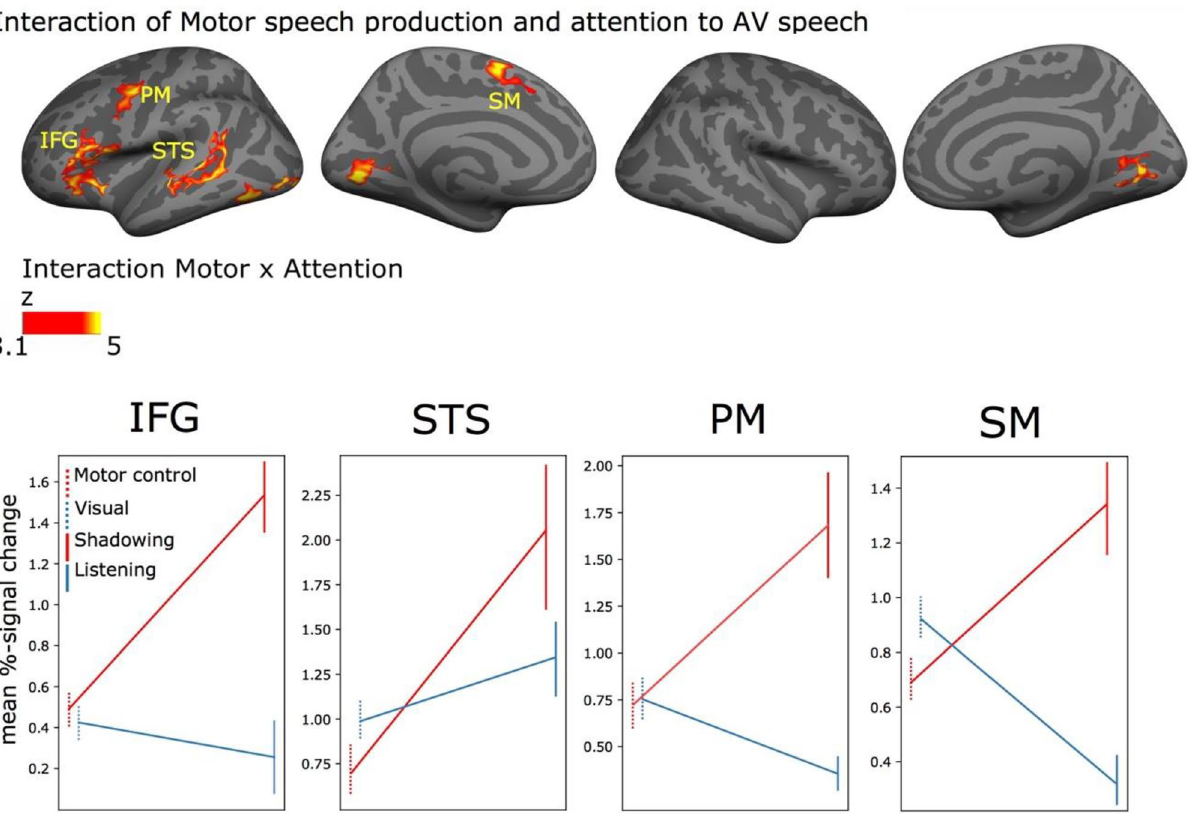
Figure 6. Significant interaction between Motor speech production and Attention to AV speech were found in left hemisphere auditory, motor and language regions. Top row: Significant clusters (initial cluster threshold z = 3.1; permutated cluster significance p < 0.05, FWER corrected) for the interaction Motor speech production × Attention to AV speech. From left to right: lateral and medial views of the inflated left hemisphere and lateral and medial views of the right hemisphere (lighter gray denotes gyri and darker gray sulci). Bottom row: The mean % signal change (vs. baseline) in each of the tasks are plotted separately for select significant clusters, Plots for all interaction clusters are shown in Supplementary Fig. 1. Error bars represent ± SEM. IFG inferior frontal gyrus, STS superior temporal gyrus, PM premotor cortex, SM supplementary motor cortex.